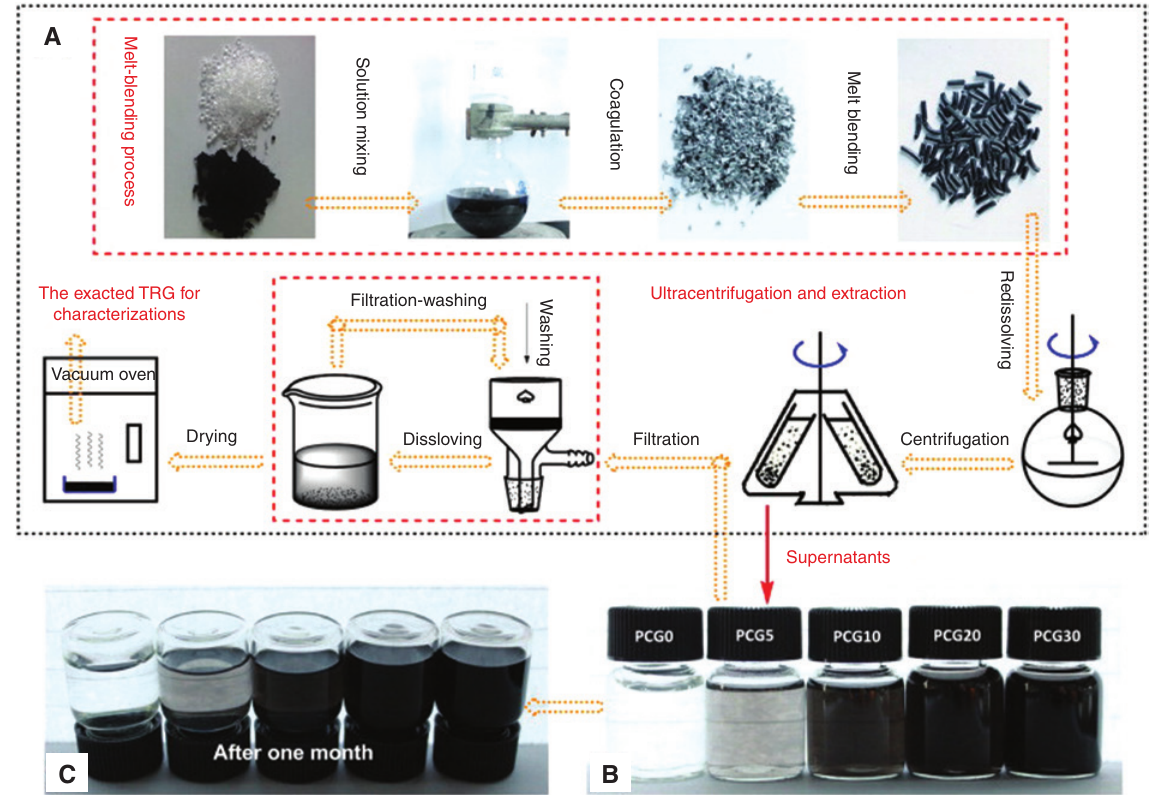
supernatants obtained by 3